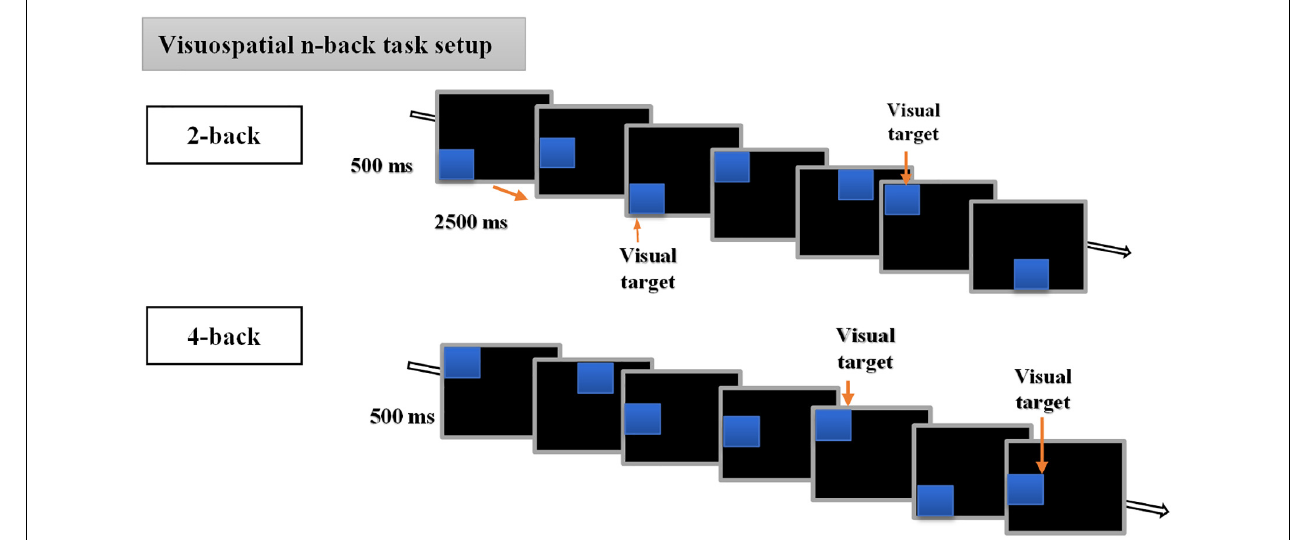
FIGURE 2 | Description of the visuospatial n-back task. The behavioral n-back task consisted of 2-back and 4-back